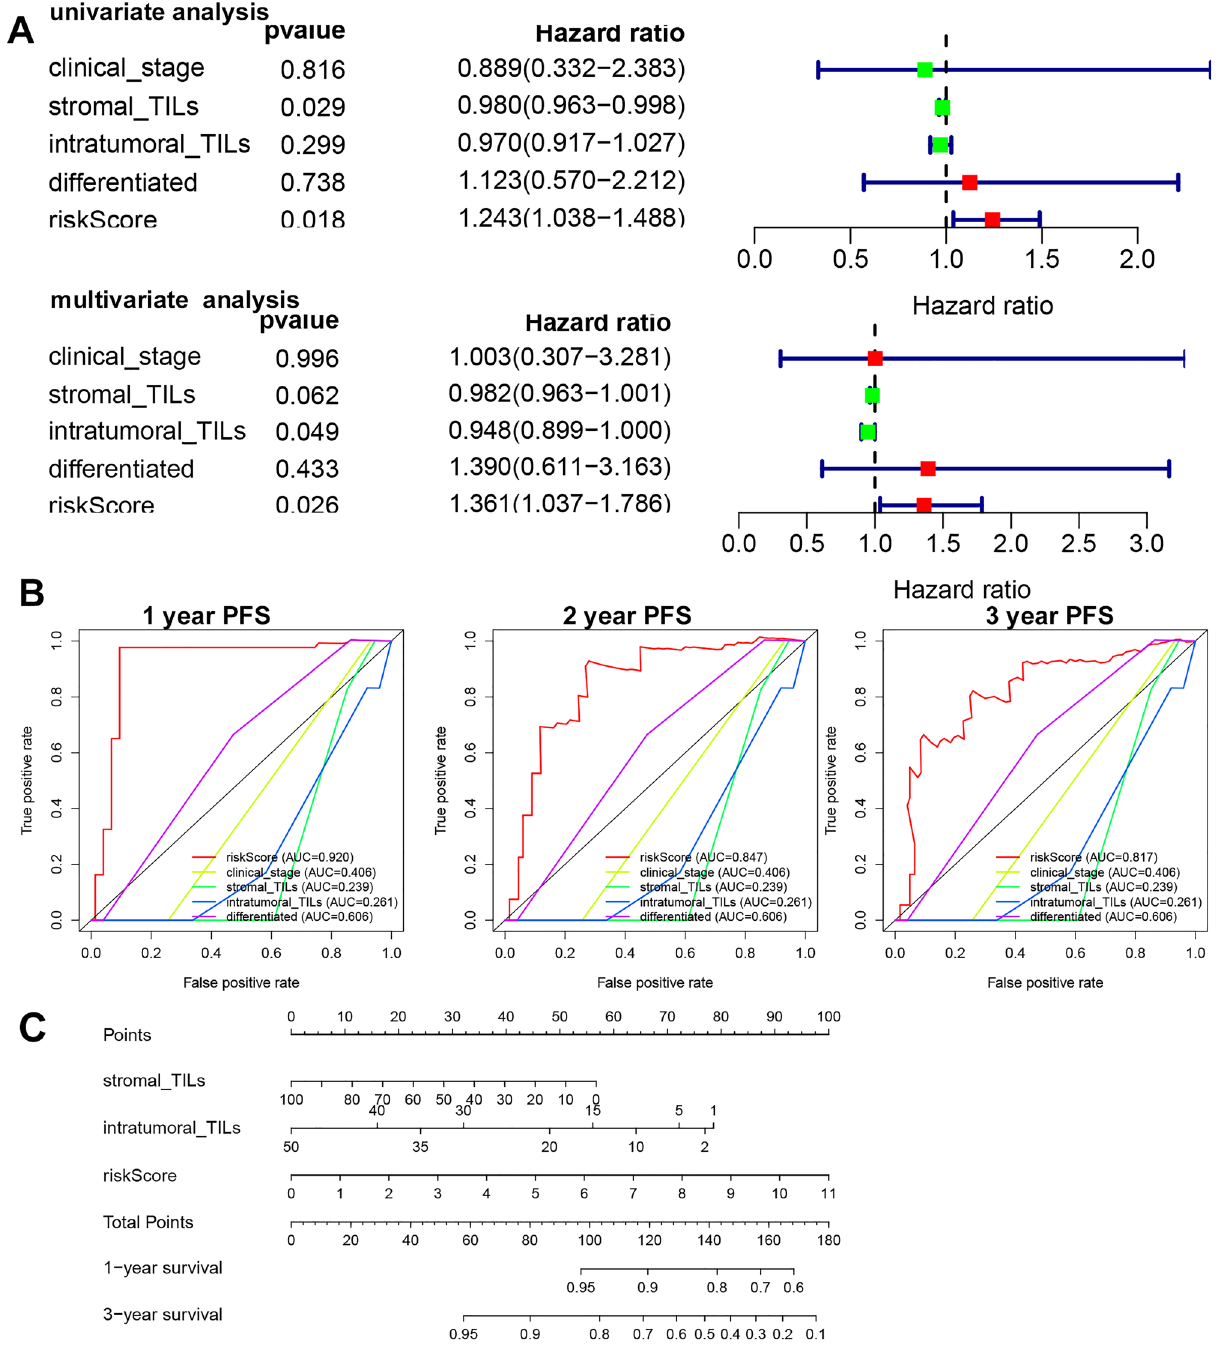
Figure 5. The independent predictive analysis. ( A ) COX regression analyses to identify prognosis signature. ( B ) The ROCs analysis to detect the predictive ability of clinical parameters. ( C ) Establishment of the poor progression-free survival nomogram for NPC